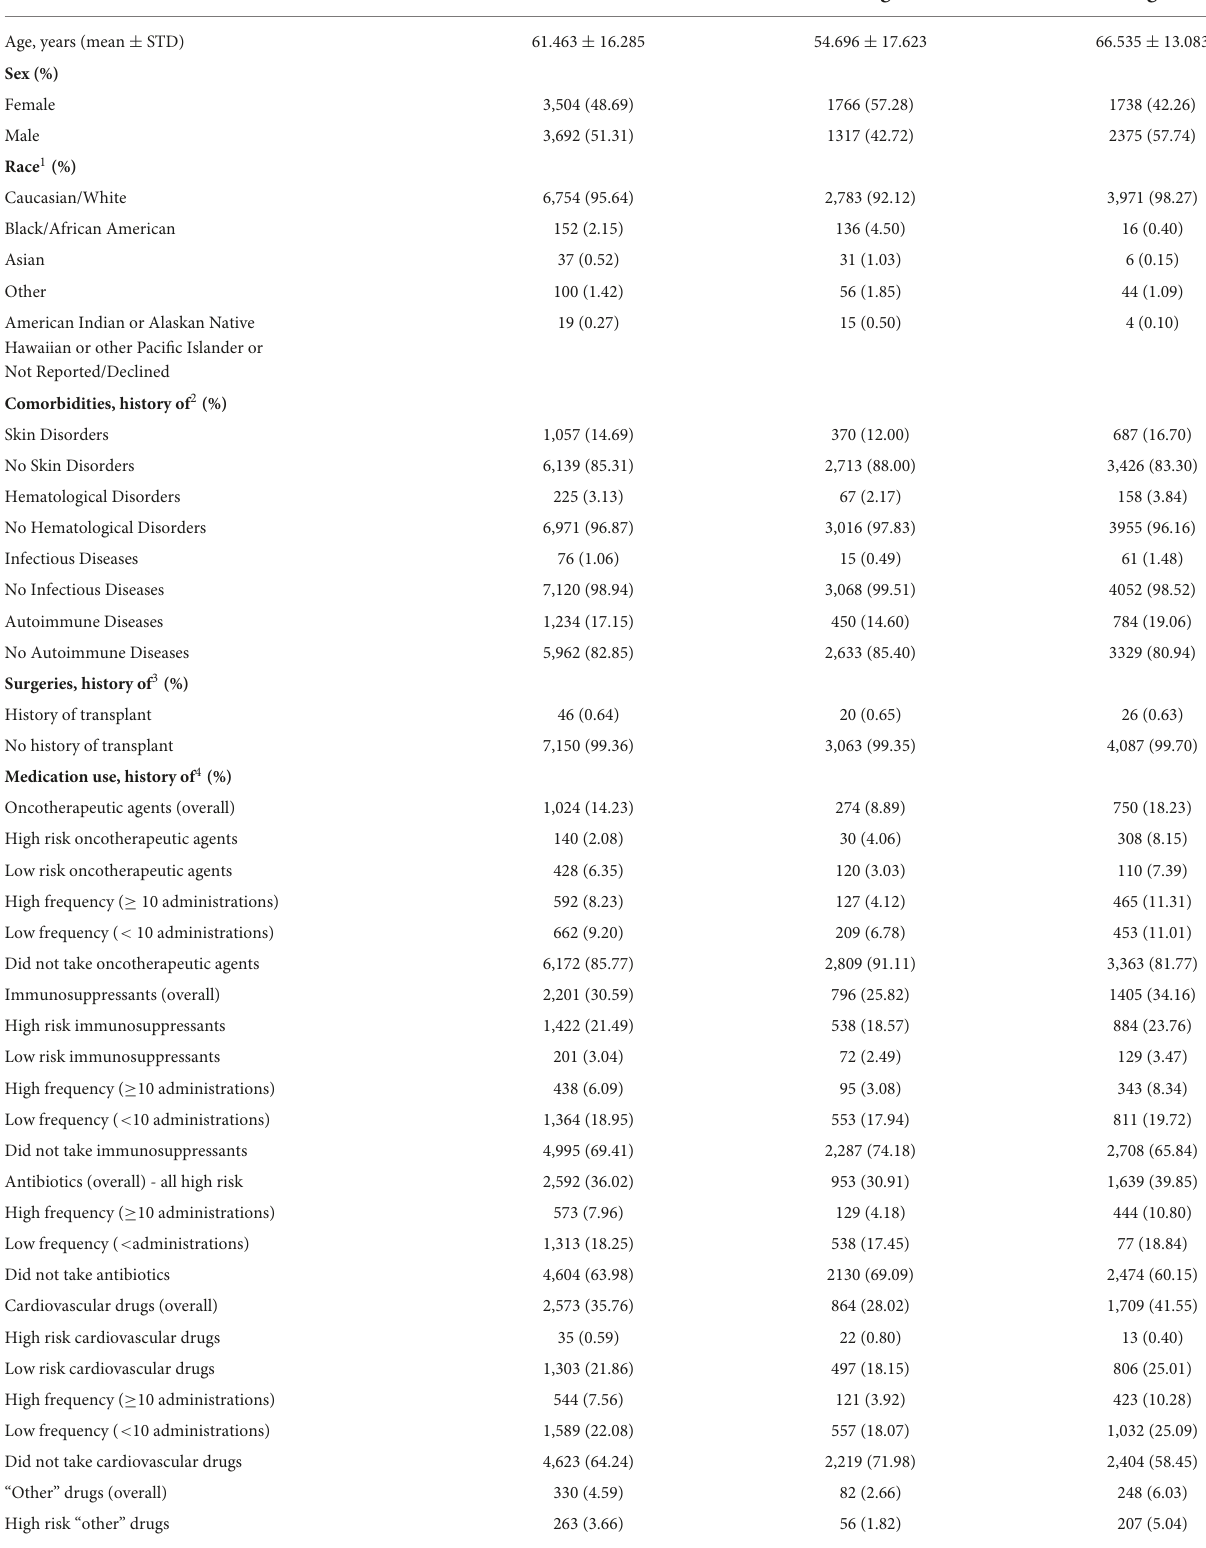
TABLE 1 Demographic and clinical data used in